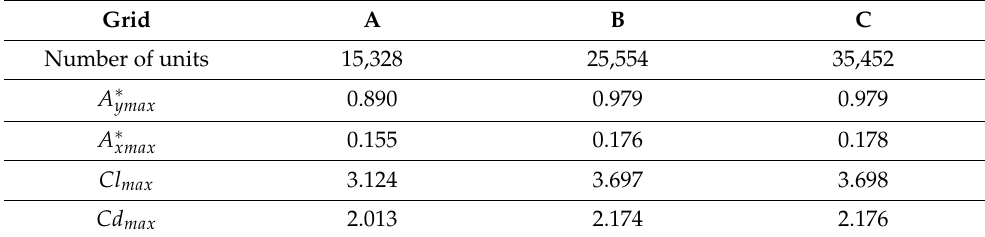
Table 2. Grid-Irrelevance Verification Results.